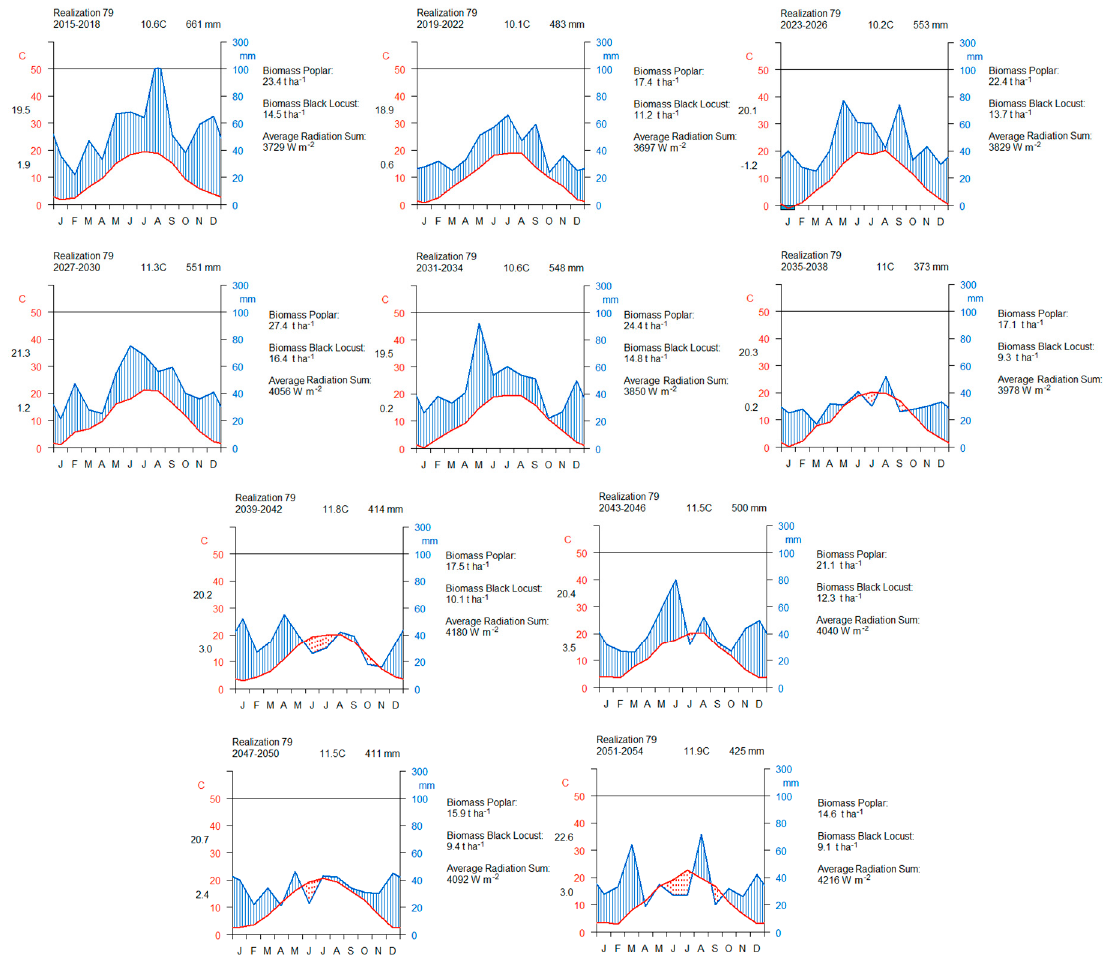
Figure A3. Walter-Lieth climate diagrams for realisation 79 in terms of average annual air temperature, precipitation and global radiation, according to the established periods and with respect to the vegetation period and accumulated woody biomass for both tree species. Forests 2018 , 9 , x FOR PEER REVIEW 20 of 24